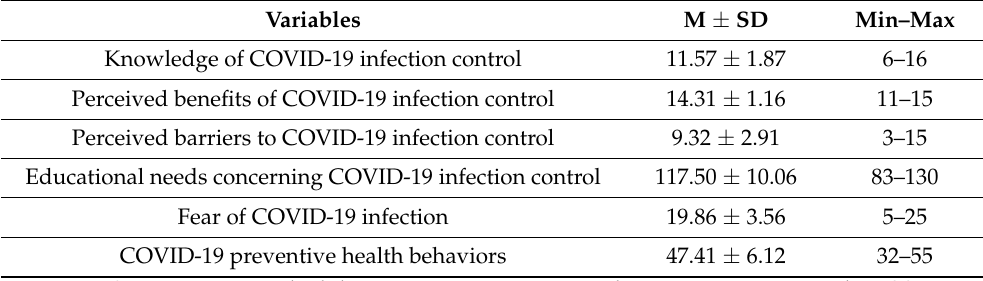
Table 2. The mean scores for COVID-19 knowledge, educational needs, fear of infection, perceived benefits and barriers, and preventive health